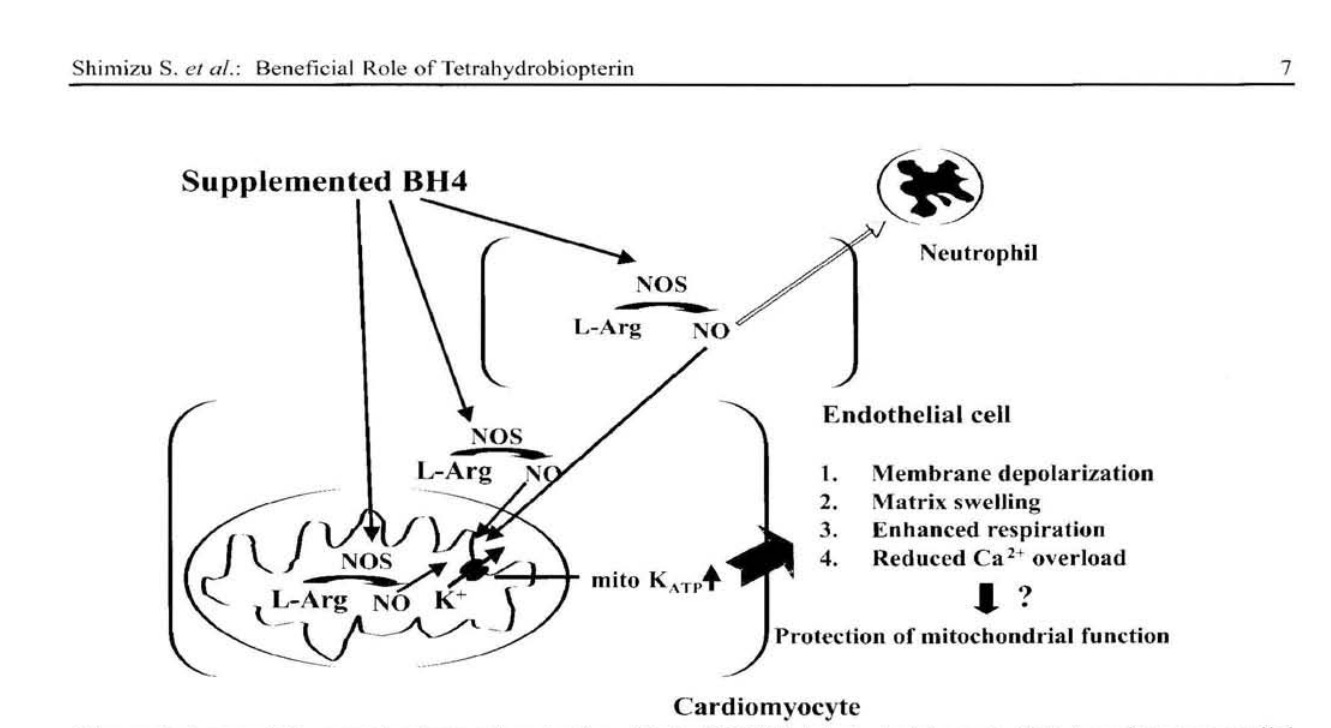
Figure 1. A speculative mechanisms of protective effect of 5,6,7,8-tetrahydrobiopterin (BH4) against myocardial infarction (L-Arg = L-arginine, NO = nitric oxide, NOS = nitric oxide synthase) dria during ischemia are unclear, opening of